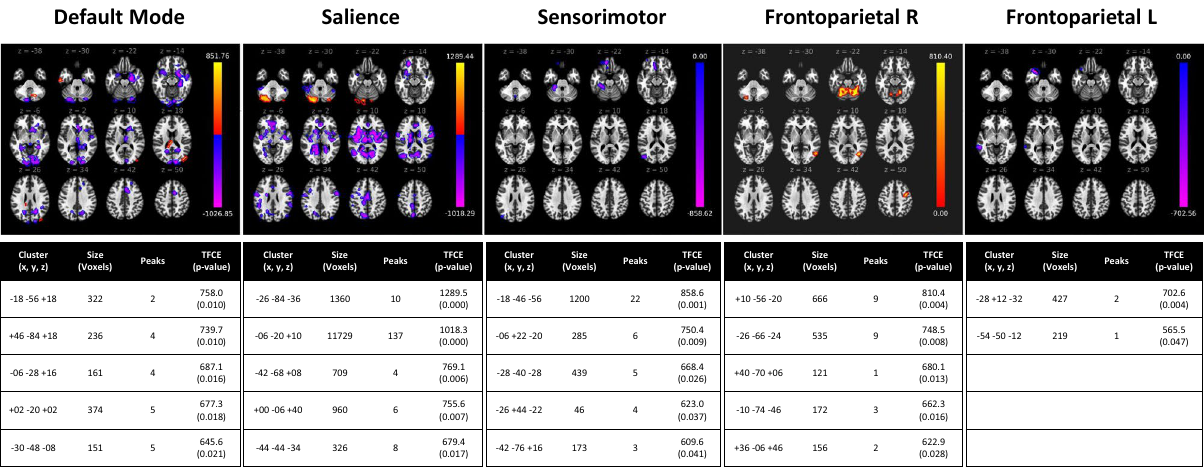
(right), occipital cortex, and precuneous cortex; (ii) SMN and the cerebellum (left), frontal pole (left), temporal fusiform cortex (left), lateral occipital cortex (left); (iii) SA and the precuneous cortex, lateral occipital cortex (left), cingulate gyrus (left), cerebellum, and precentral gyrus (left); FPN-L and the temporal pole (left), and mid- dle temporal gyrus (left). Further, there was increased functional connectivity between the seed-region of the: (i) DMN and cerebellum, lateral occipital cortex (right); SA and the cerebellum; FPN R and the cerebellum, lateral occipital cortex (right), precentral gyrus (right). These data are depicted in Fig. 1. At the ROI-to-ROI level, there was a broad pattern of decreased functional connectivity between multiple brain regions bilaterally, and fewer instances of increased connectivity between pairs of ROIs. The clusters of